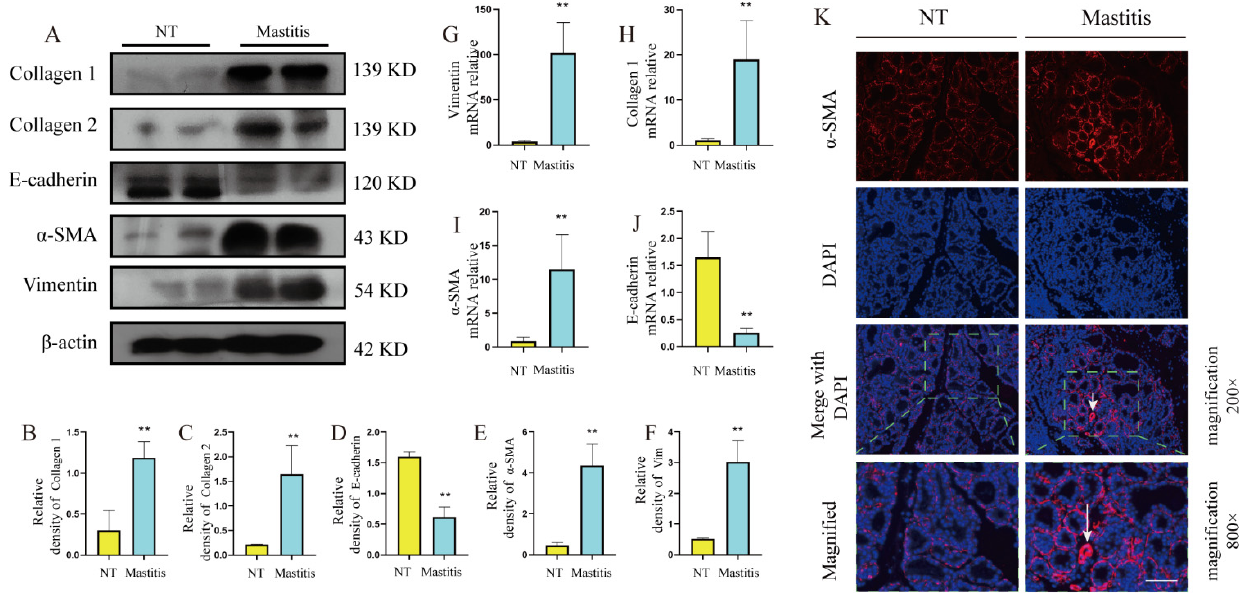
Figure 3. Phenotypic changes of fibrosis in mammary gland tissue of healthy dairy cows ( n = 10) and mastitis dairy cows ( n = 10). ( A ) The protein levels of collagen 1, collagen 2, E-cadherin, α -SMA, vimentin, and β -actin in the mammary gland. ( B – F ) Quantification of collagen 1, collagen 2, E-cadherin, α -SMA, vimentin protein levels in mammary tissue, relative to β -actin. ( G – J ) The mRNA expression levels of vimentin, collagen 1, α -SMA, E-cadherin, in mammary tissues. ( K ) Immunofluorescence results of α -SMA, scale bar 200 µ M. Data were analyzed by the unpaired t -test method. The data error is presented in the form of mean ± SEM. The results of the experiment are the result of three independent repeated experiments. ** p < 0.01 compared with the control group.